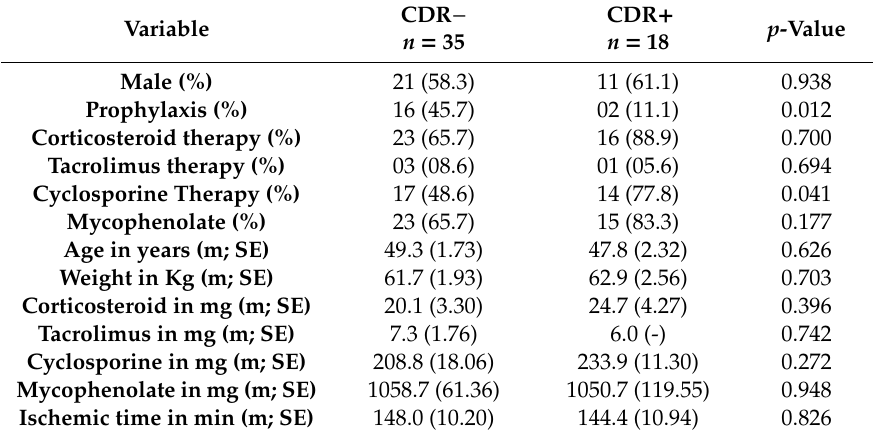
Table 2. Characteristics of patients with (CDR + ) and without (CDR − ) Chagas disease